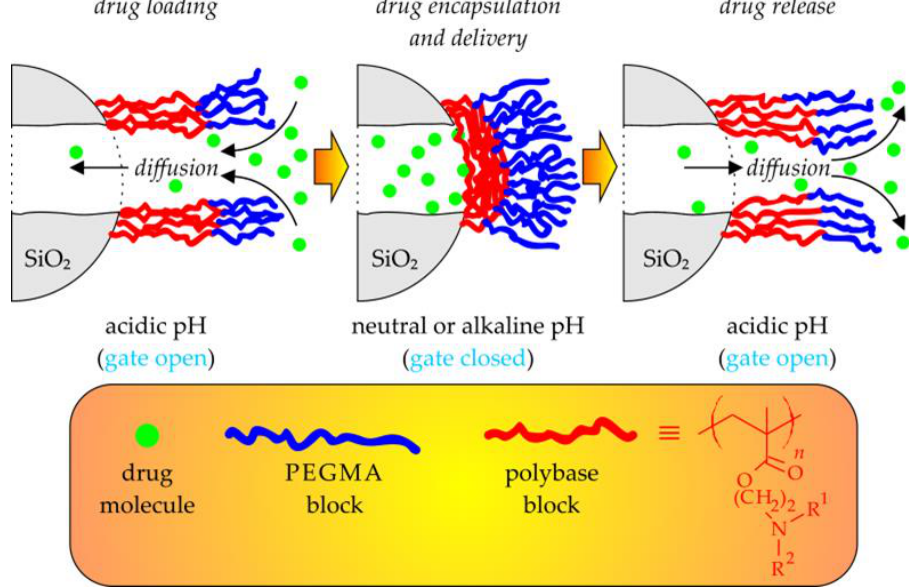
Figure 11. Schematic illustration of drug loading, delivery, and release from the surface-modified HNPs containing mesoporous silica cores. HNPs containing mesoporous silica